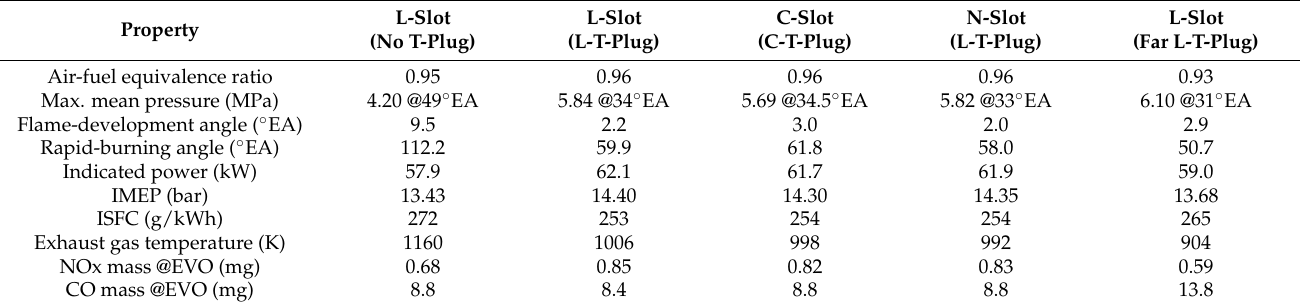
Table 4. Simulation results for different slot positions in Wankel engine with three-plug arrangement.